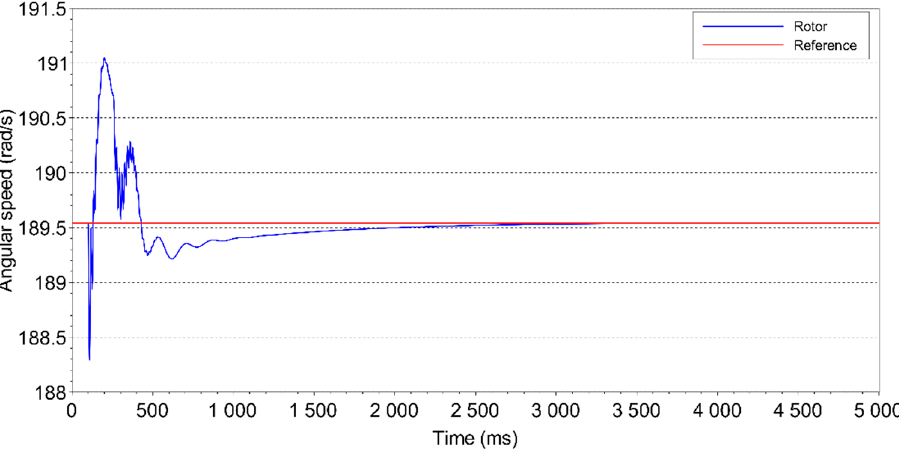
Figure 16. Rotor speed for ride-through analysis.